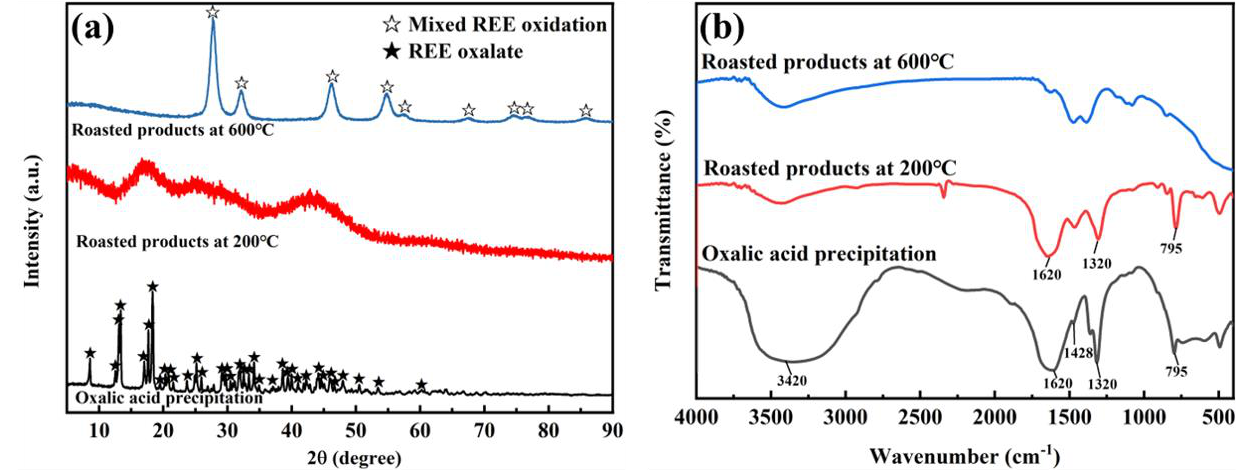
Figure 12. XRD ( a ) and FTIR ( b ) curves of oxalic acid precipitation products and their roasted products at 200 °C and 600 °C.